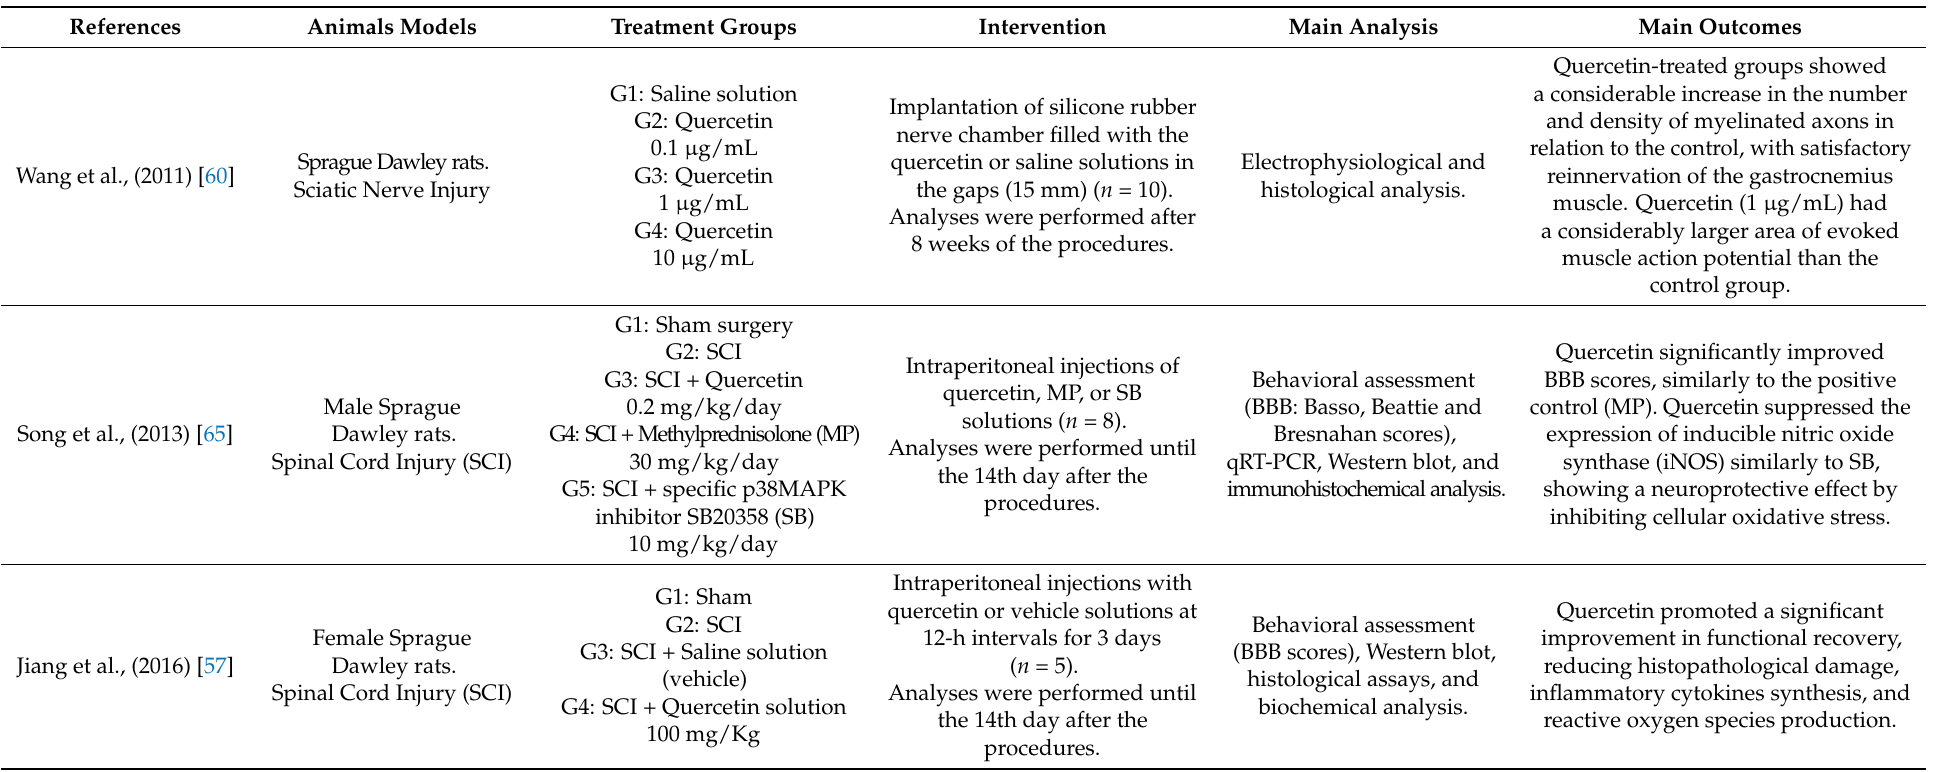
Table 1. In vivo studies that evaluated the effect of quercetin administration in animal models with spinal cord injury (SCI) or peripheral nerve injury (sciatic